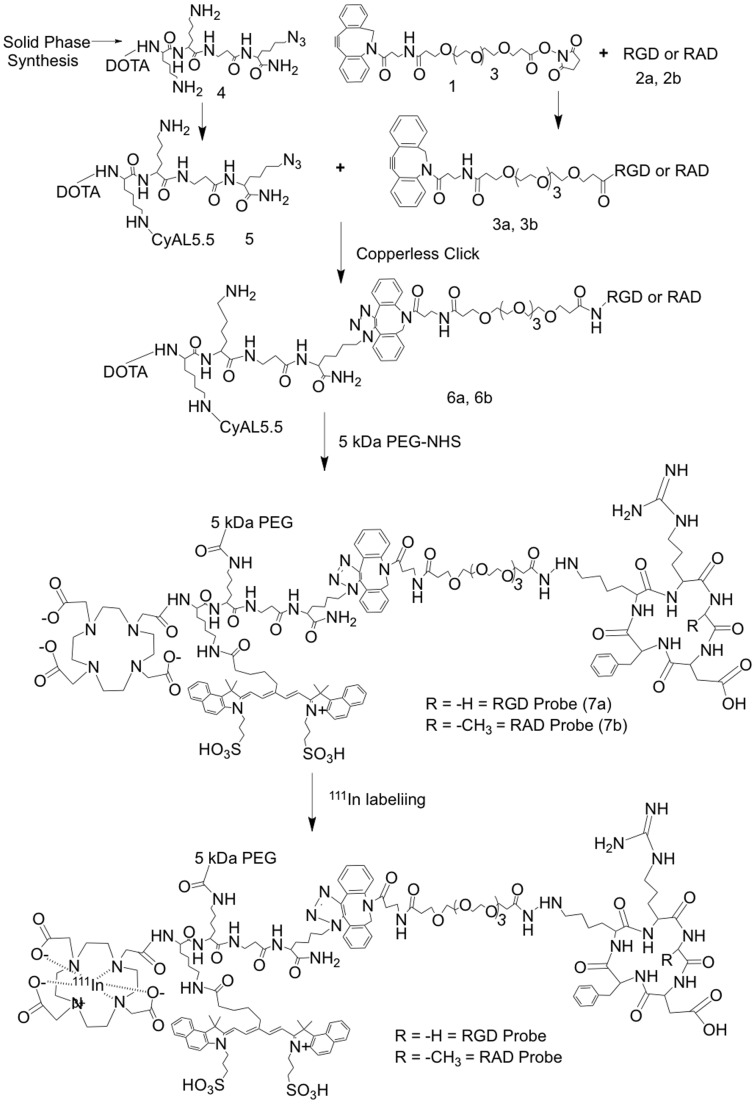
Synthesis of RGD and RAD probes.The general strategy used to synthesize the RGD probe (7a) and RAD probe (7b) is shown.